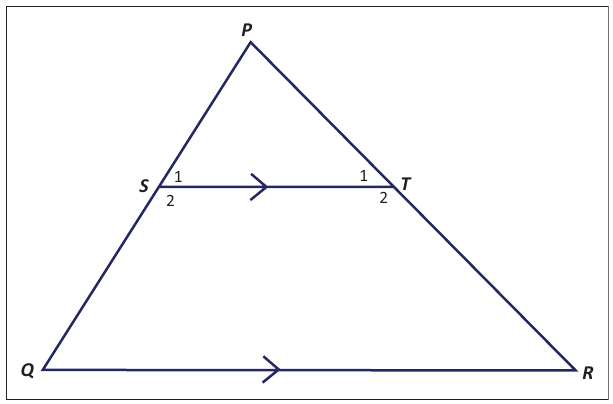
FIGURE 2: Corresponding angles of similar